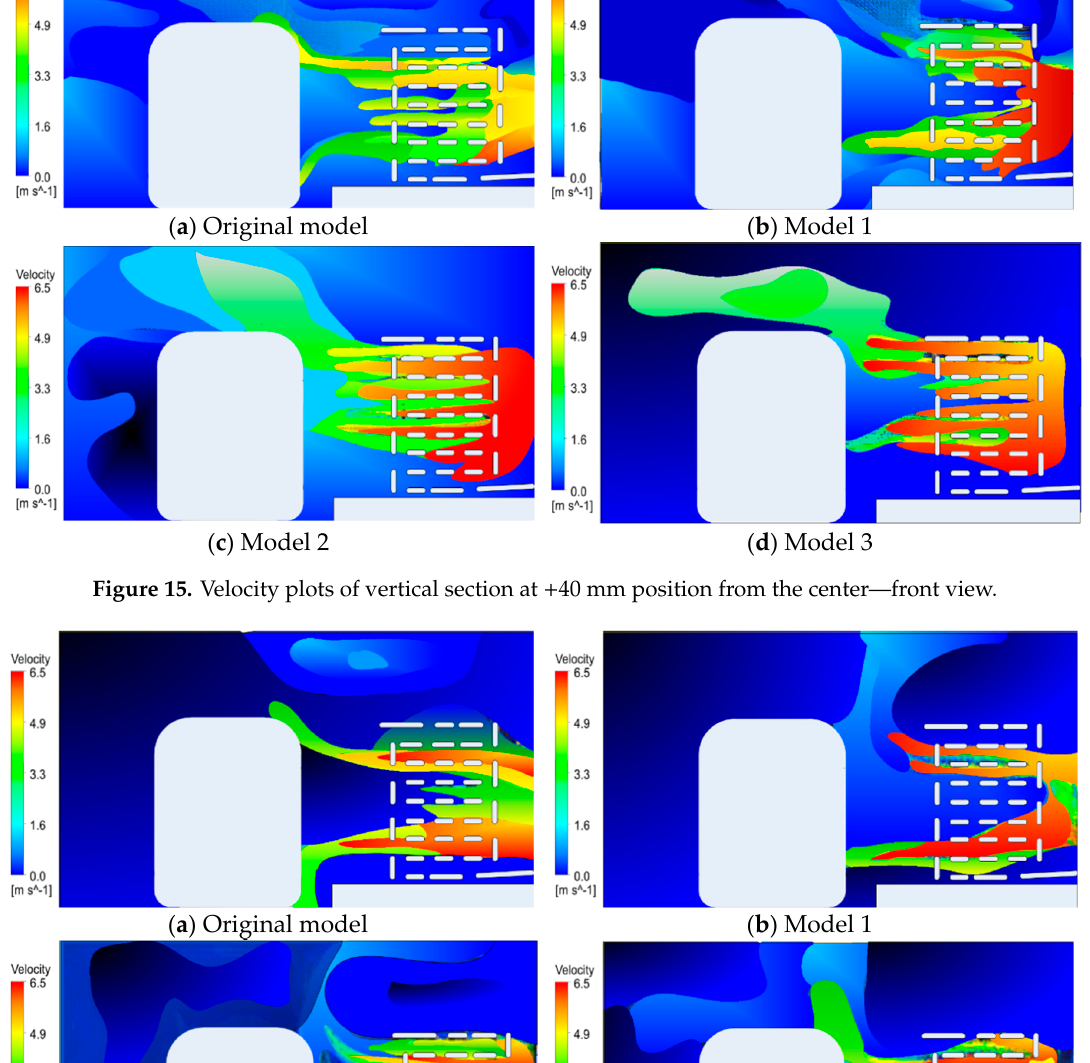
Figure 16. Velocity plots of vertical section at − 20 mm position from the center—front view.